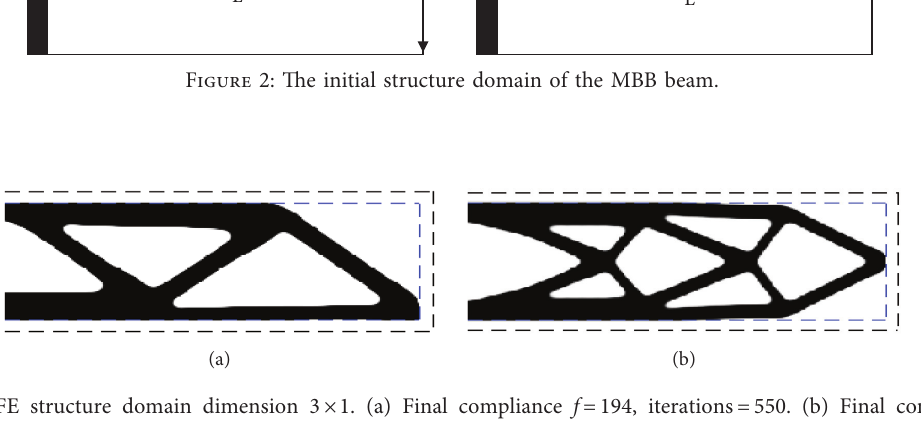
� 3, r � 3, r � 5, c � 20, and iter- ɸ min max Φ